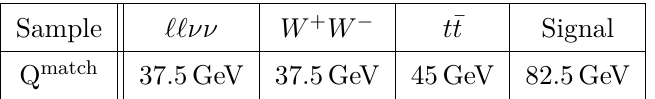
Table 3 . Parameters for the multi-parton matrix element merging procedure, including the scale for background samples and for signal